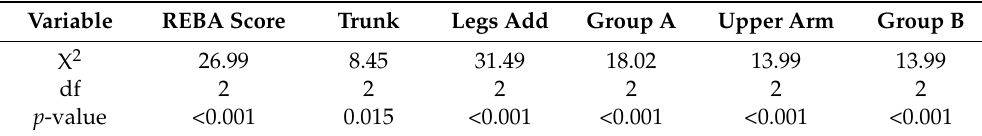
Table 3. Testing the postural load difference between the chainsaw starting methods using the Kruskal-Wallis H